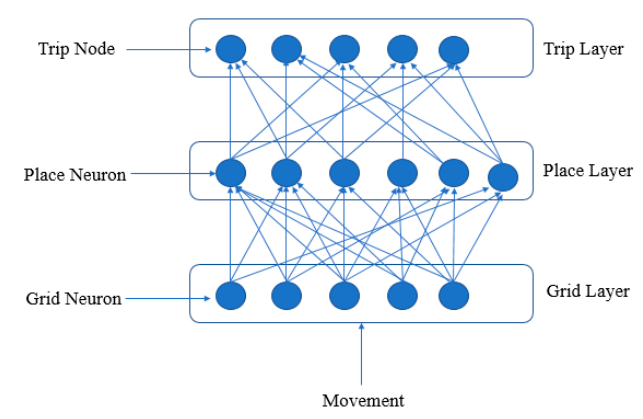
Figure 14. Place sequence learner.